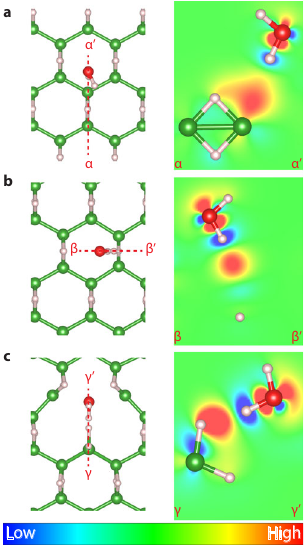
Fig. 6 Charge density difference of water-adsorbed HB sheet. Charge density difference Δρ (right) and corresponding slice position (left) of water-adsorbed on ( a ) pristine, ( b ) H-vacant, and ( c ) B-vacant HB sheet. Red (blue) indicates electron accumulation (depletion). The low/high saturation limit for ( a ), ( b ), ( c ) are ±0.014, ±0.027, and ±0.027 e Å − 3 ,